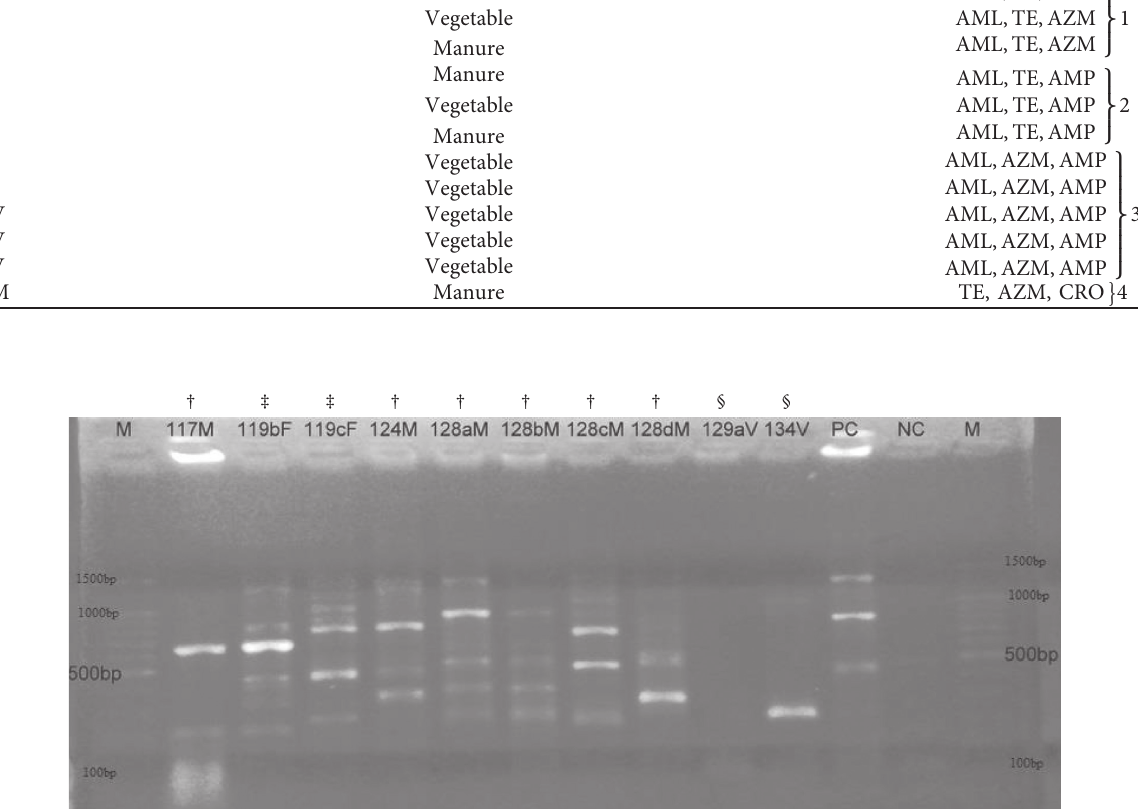
Figure 2: Representative DNA fingerprints from ERIC-PCR of E. coli isolates from manure, vegetable, and fish samples identified as follows: † , isolates from manure; § , isolates from vegetable; ‡ , isolates from fish; PC, positive control ( E. coli K-12); NC, negative controls; M, 100 base pairs (bp) DNA